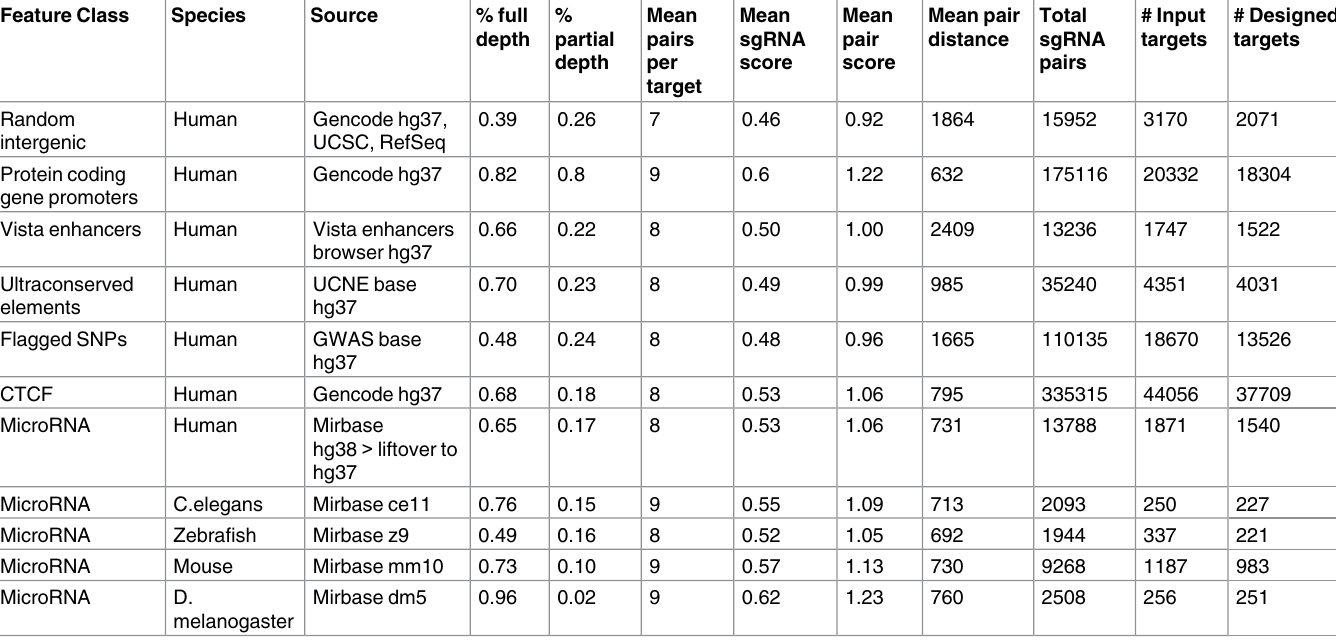
Table 4. Pre-generated paired CRISPR